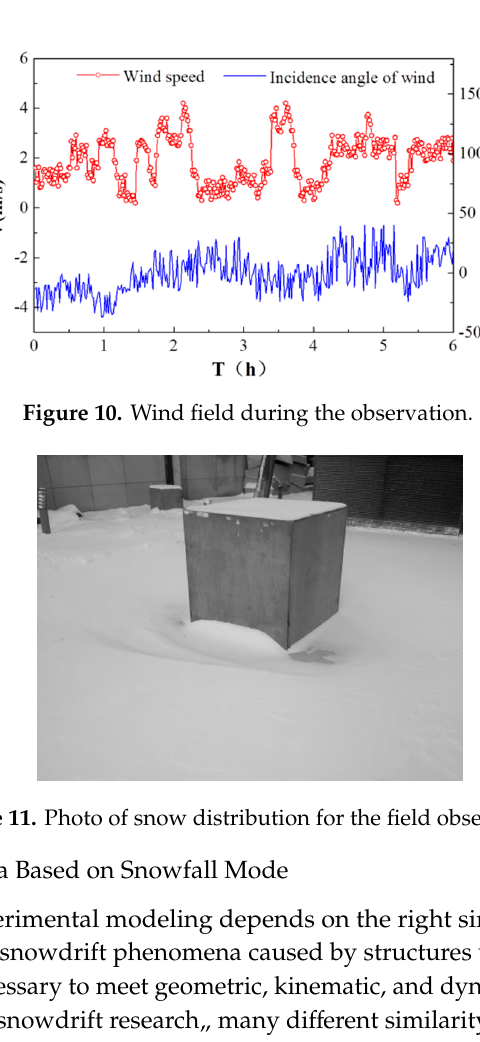
Figure 9. Abridged general view of field observation.